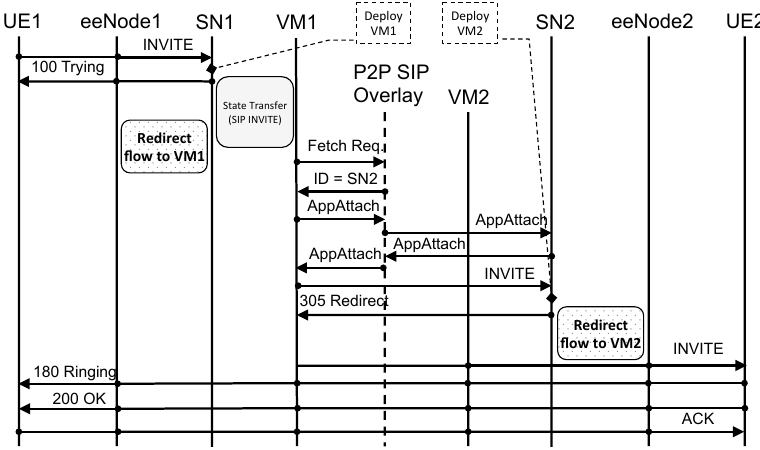
Figure 15. VoLTE call initiation with